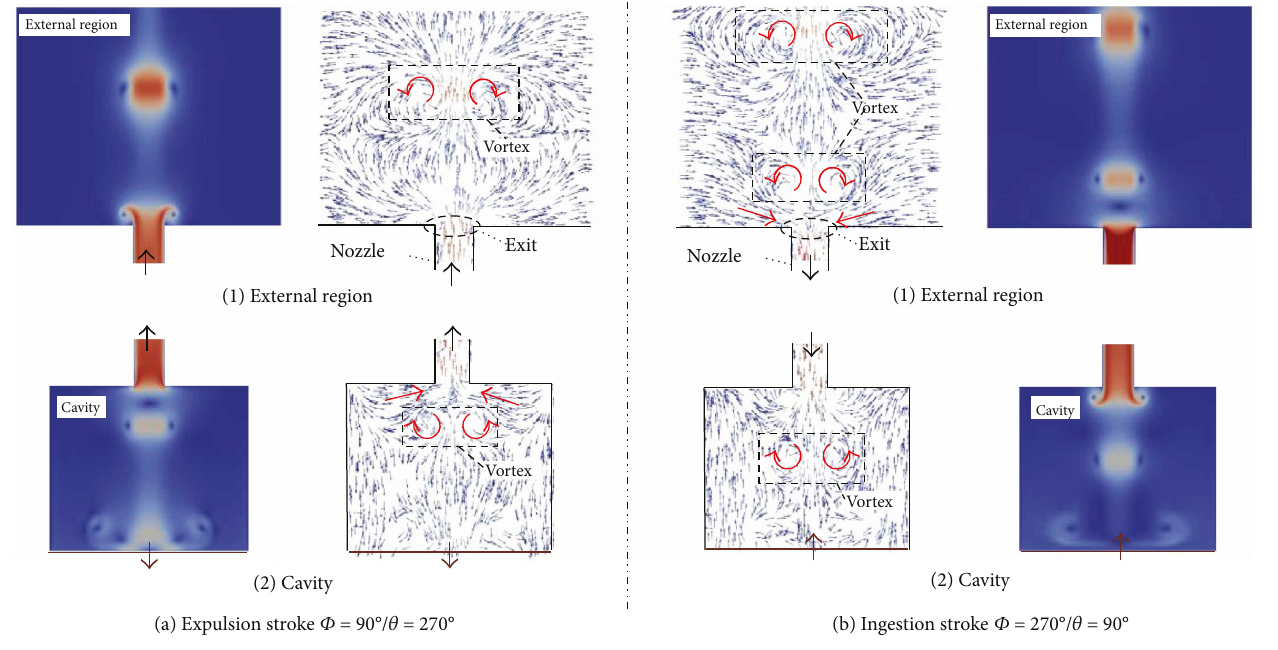
Figure 10: Vector distribution of phase-averaged velocity at cross section A at Φ =90 ° and 270 °